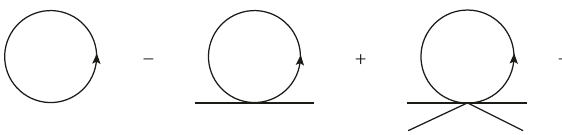
Figure 1: One-loop contributions to the renormalization of 𝛼 𝑛